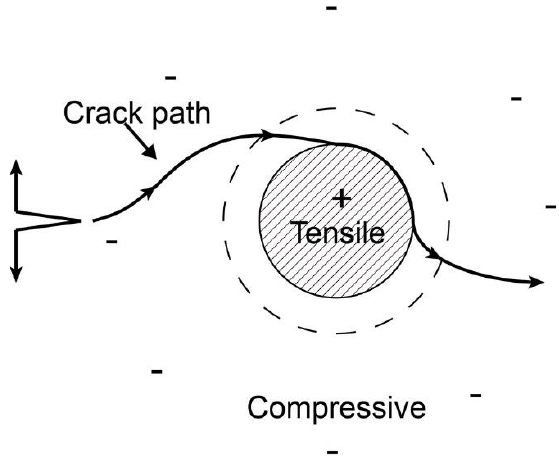
Figure 12. Toughening mechanism by thermal residual stress. Deflection of the crack by the particle and associated matrix stresses. The crack moving in the plane of the particle will first be deflected. As the crack moves around the particle, it can be attracted to the particle interface.